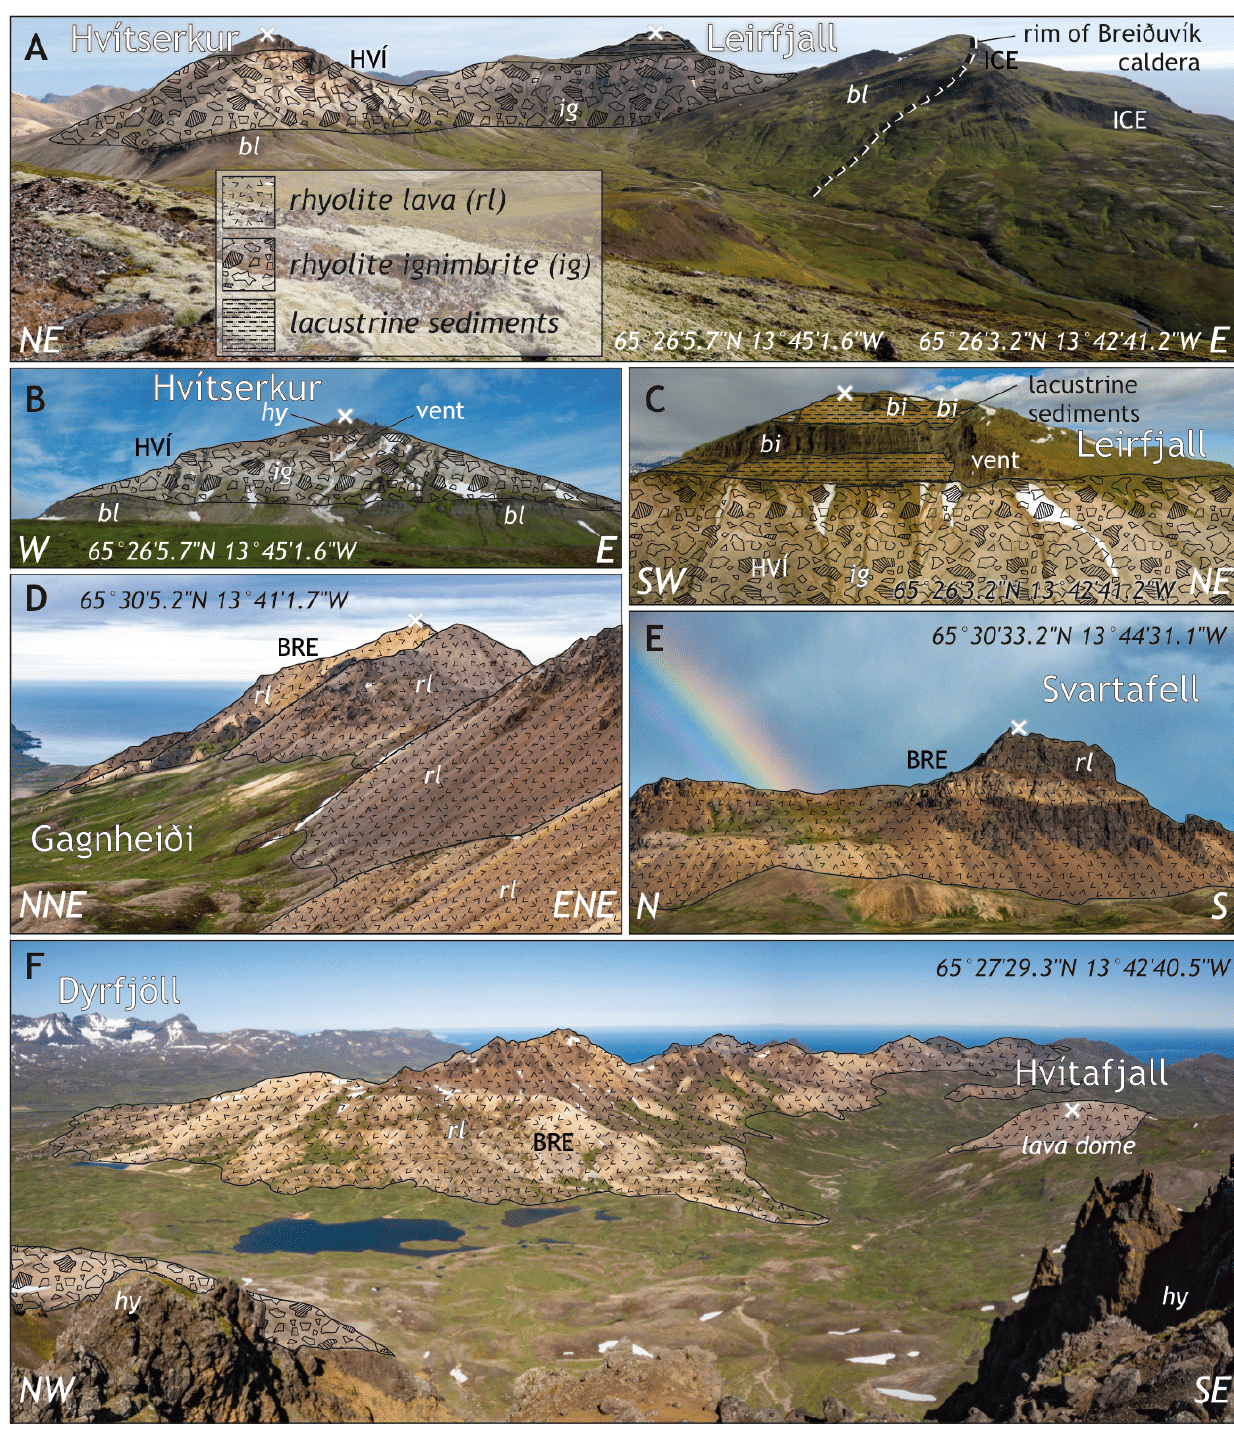
Figure 8: Annotated field photographs illustrating the geology of Breiðuvík. For locations see Figure 7. Abbrevi- ations: b = basalt, r = rhyolite, hy = hyaloclastite, l = lava, i = intrusion, ig = ignimbrite. × marks the location of the coordinates mentioned in each photograph. For names of stratigraphic formations, see text and Figure 13. [A] Panoramic view of the Breiðuvík caldera with the caldera-infill Hvítserkur ignimbrite and the overlying caldera lake sediments marked. [B] Southern flank of Hvítserkur showing the landmark ignimbrite crosscut by dark basaltic dykes. The top of the mountain is formed by basaltic hyaloclastite erupted in the caldera lake overlain by subaerial lavas. [C] southern flank of Leirfjall. The Hvítserkur ignimbrite is overlain by clastic lacustrine sediments intruded by basaltic dykes and sills. [D] The colourful mountains near Gagnheiði consist of rhyolitic lava flows. [E] Thick rhyolitic lava flow forming the top of Svartafell. the layered appearance is a result of different jointing directions in the rhyolite lava. [F] View from the top of Hvítserkur. The mountains between Breiðuvík and Borgarfjörður eystri consist of rhyolitic lavas and lava domes. Hvítafjall is the remnant of a lava